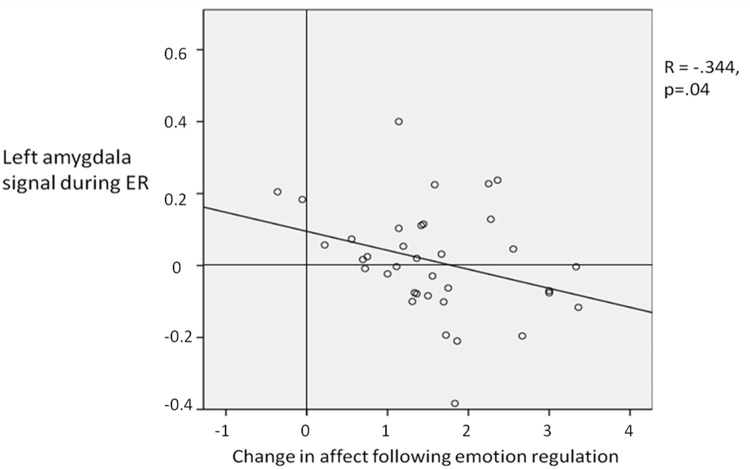
Correlation between the left amygdala signal during emotion regulation and the reduction in self report affect rating as a result of emotion regulation.The greater the reduction in affect rating rating is indicative of more successful emotion regulation (i.e. a larger reduction in affect ratings for the emotion regulation compared to not regulating emotion).